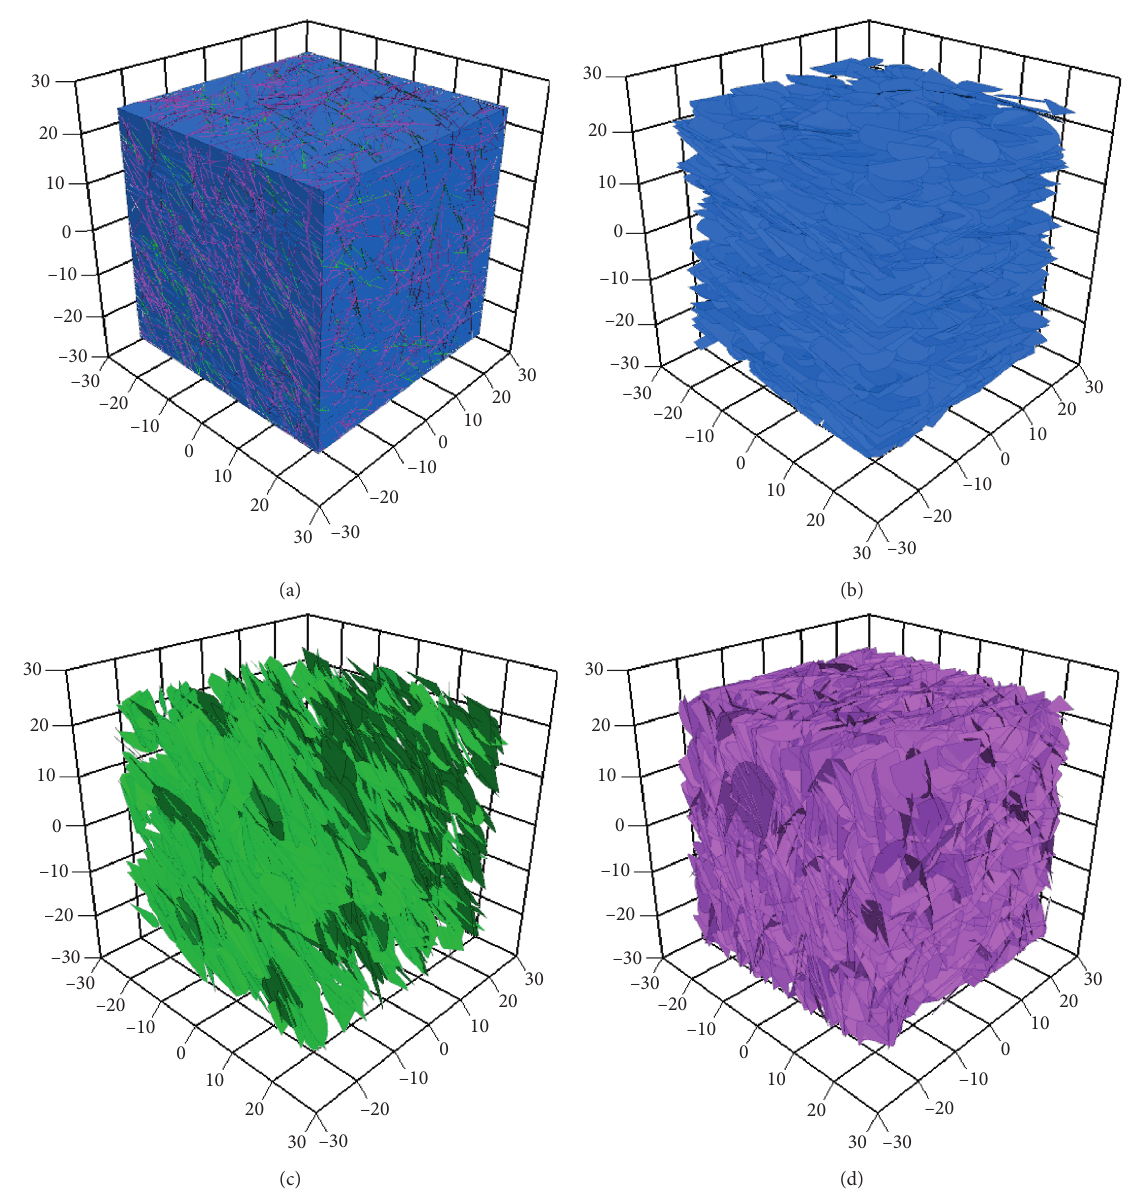
Figure 2: Illustration of 3D fractures (spacing: 1 m; trace length: 8–14 m): (a) 3D plane network model; (b) dominant group set 1; (c) dominant group set 2; (d) dominant group set